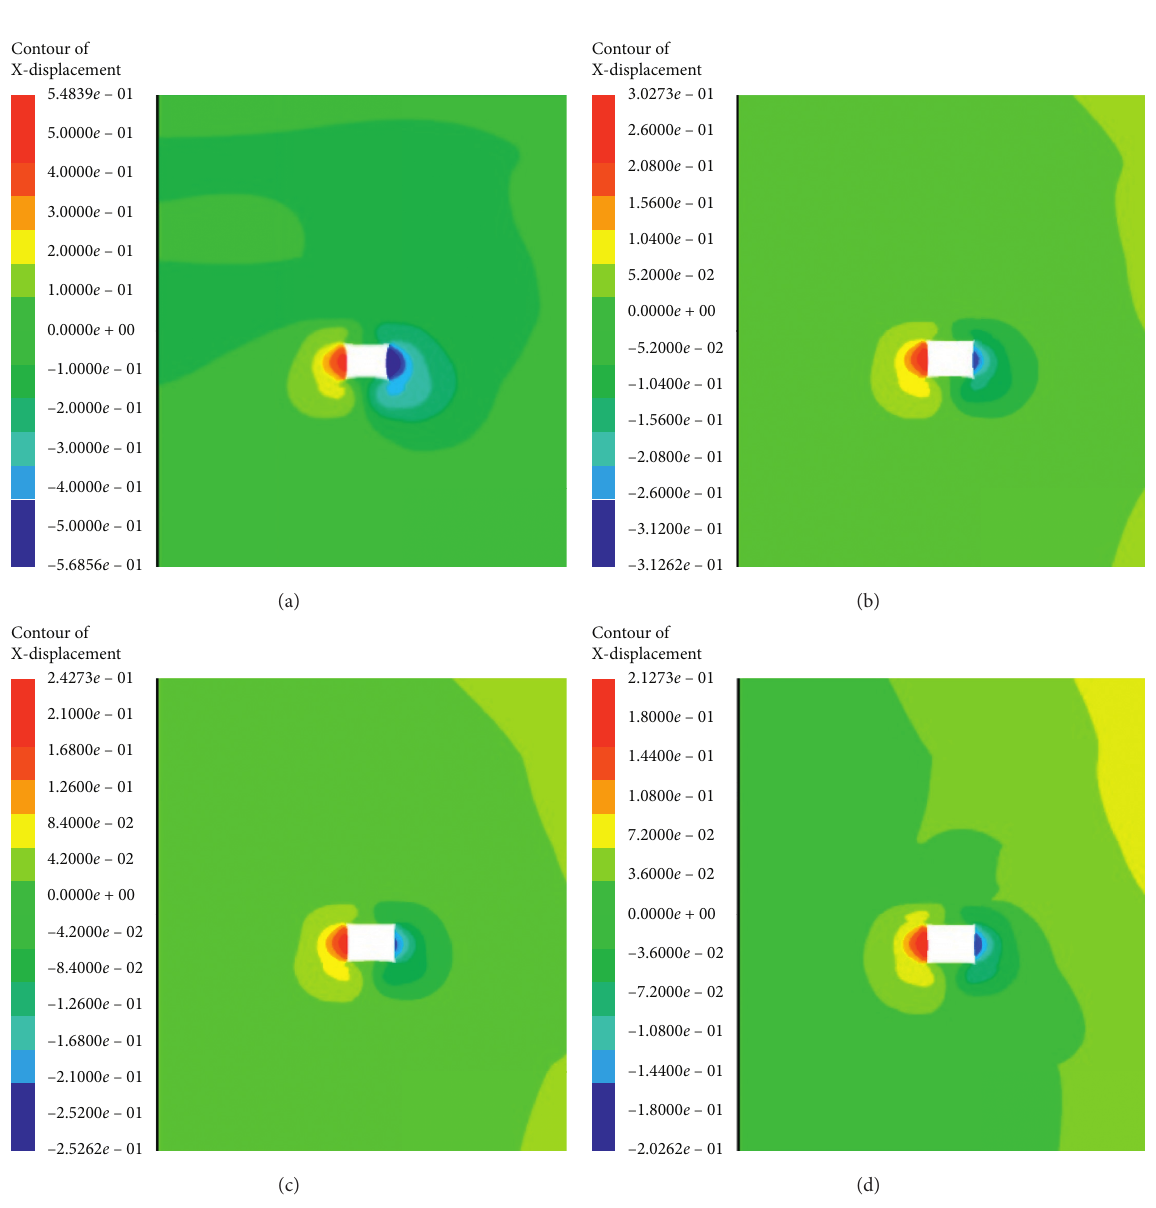
Figure 12: Deformation of the coal wall: (a) cutting height 0m; (b) cutting height 10 m; (c) cutting height 12m; and (d) cutting height 14m. Table 5: Deformation and stress of the roadway with different roof cutting heights. Cutting